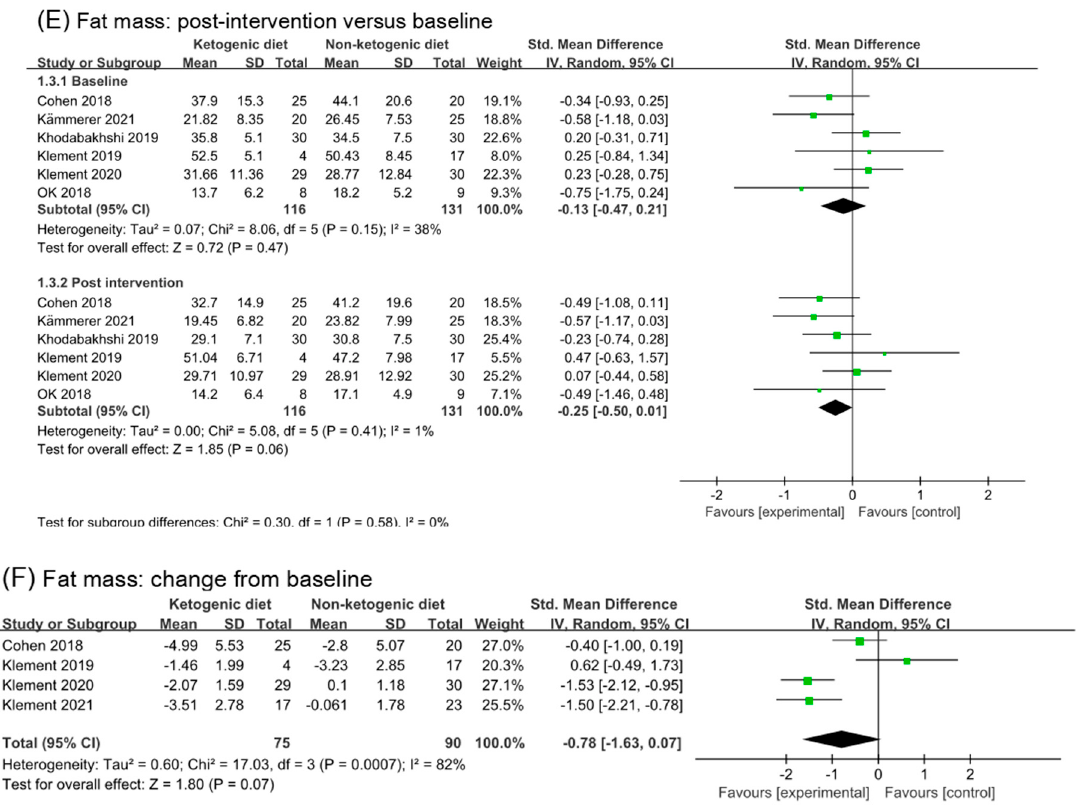
Figure 3. Forest plot for the effects of ketogenic diets on body weight, BMI and fat mass. ( A , B ) were subgroup effects of the baseline versus post-intervention and effect of change from baseline on body weight; ( C , D ) were ones on BMI; ( E , F ) were ones on fat mass [26–42].